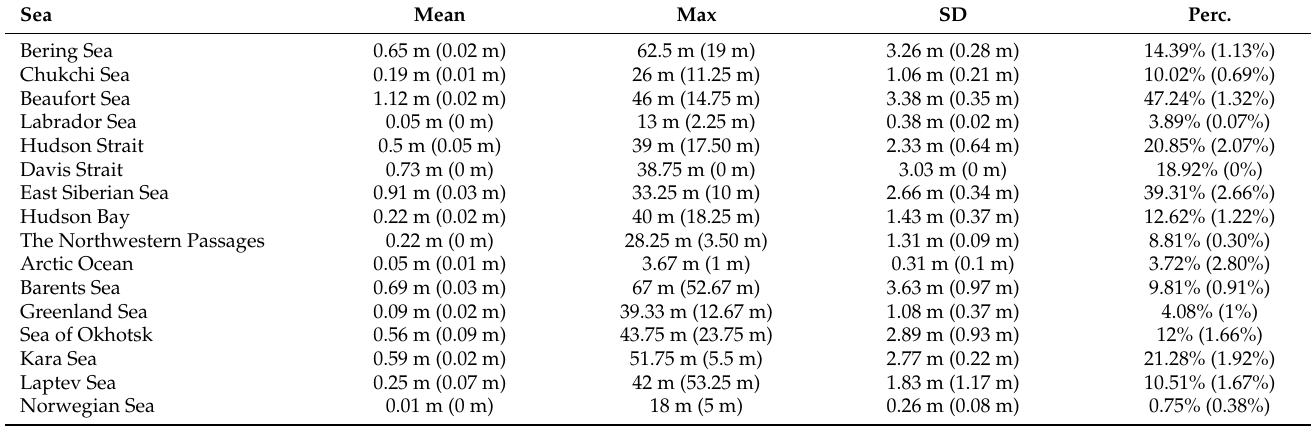
Table 3. Change Vector Analysis (CVA)-based annual erosion and build-up statistics per sea after the International Hydrographic Organization (IHO) sea areas and based on 400 m segments. The average, maximum, and the standard deviation (sd) are given. In addition, the percentage of segments with coastal change is provided. Build-up statistics are written in parentheses. Statistics are based on all segments, including segments with no coastal